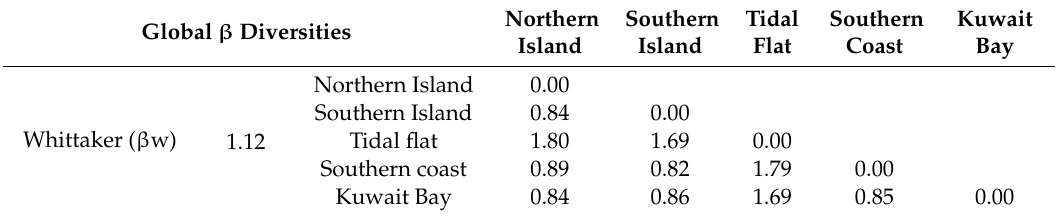
Table 2. β w diversity values calculated for the northern islands, southern islands, tidal flat southern coast and Kuwait